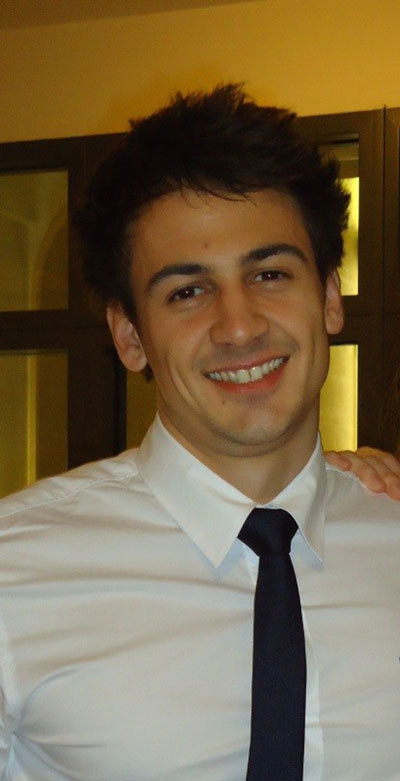
Laurent Van Camp